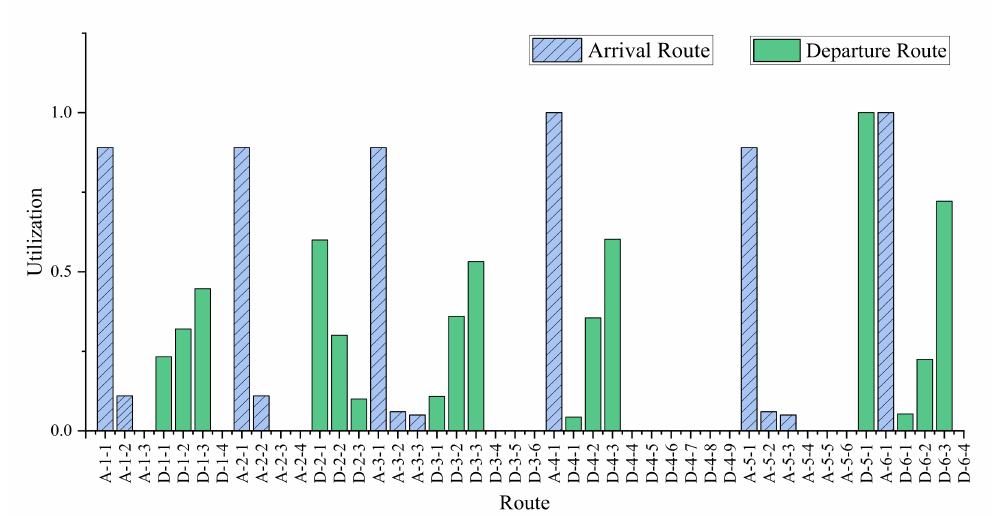
Figure 11. Utilization rate of